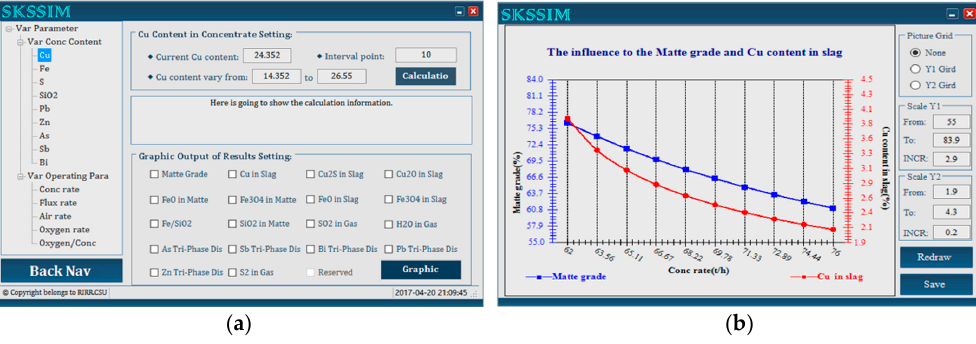
Figure 6. Interfaces in the variable working condition: ( a ) input interface; ( b ) output interface.